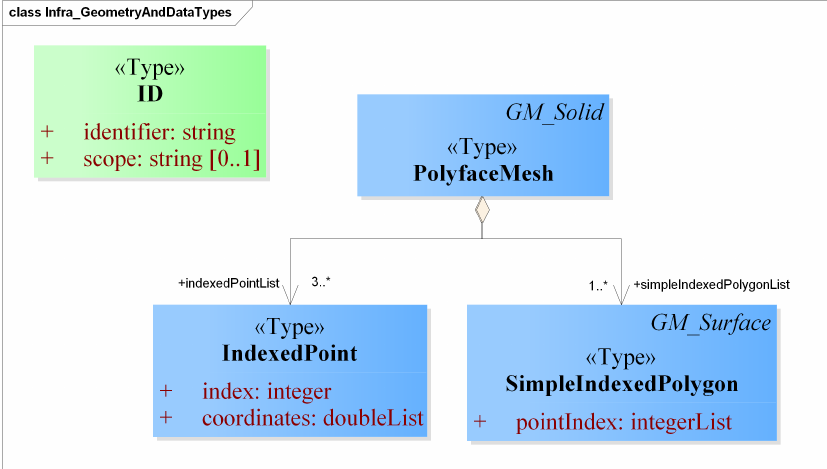
Figure A2. The UML excerpt depicts the new data type ID and three new LandInfra specific geometry types implemented in the CityGML Infra